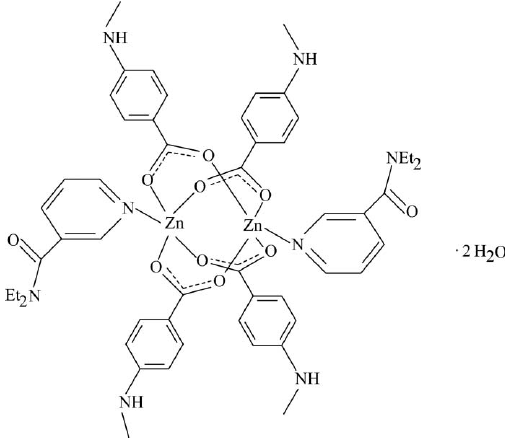
Experimental Crystal data